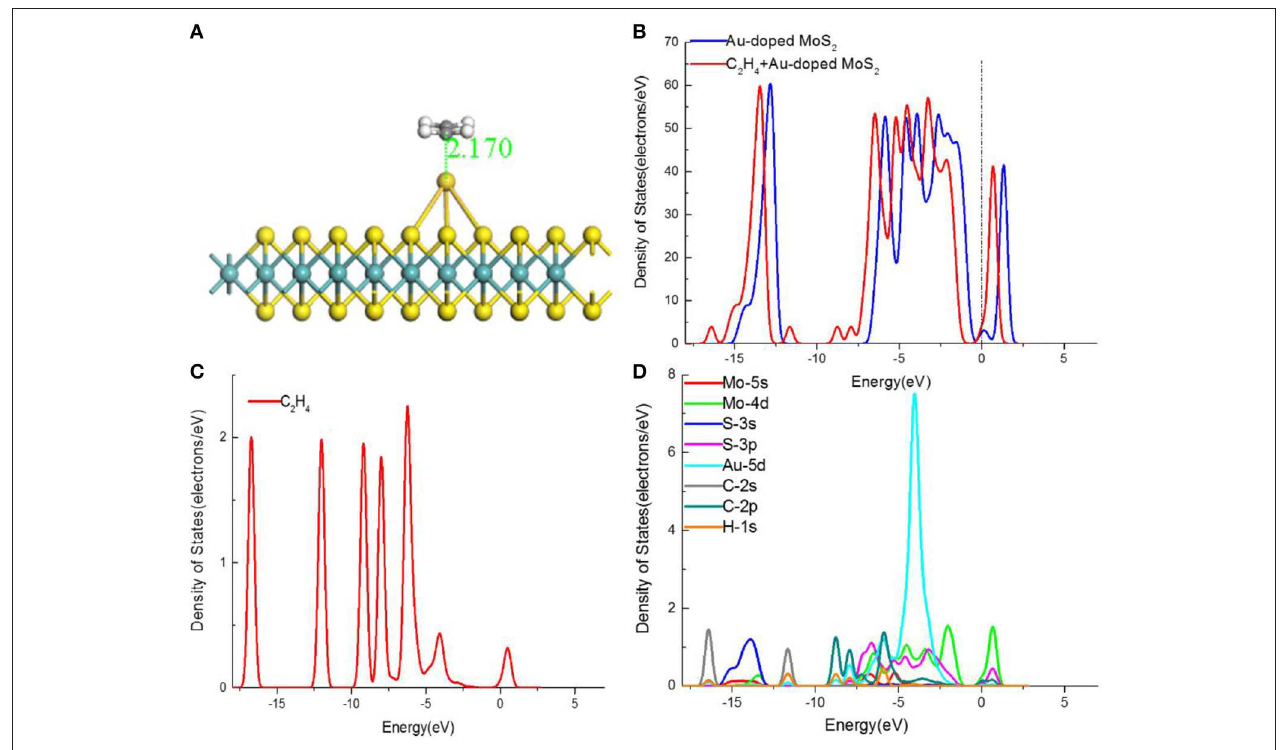
FIGURE 6 | (A) The structures, (B) TDOS, (D) PDOS of C 2 H 4 -adsorbed MoS 2 monolayer, and (C) the TDOS of C 2 H 4 molecular.